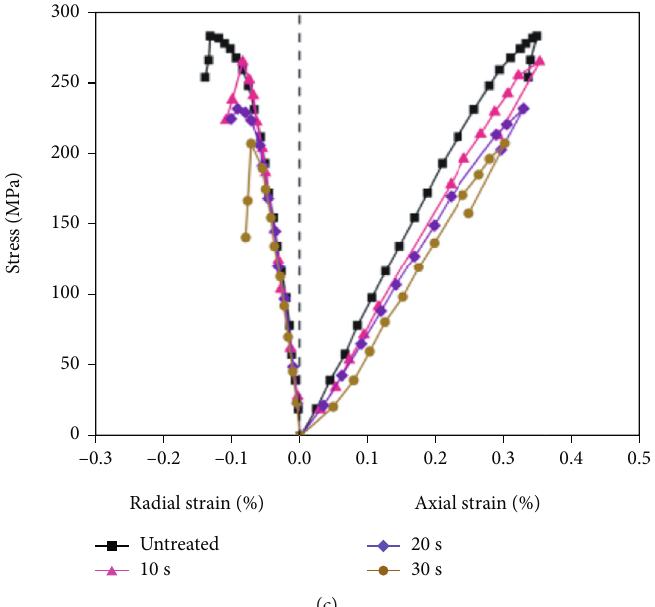
Figure 7: Stress-strain curve of the basalts before and after microwave irradiation: (a) power density is 1 kW; (b) power density is 3 kW; (c) power density is